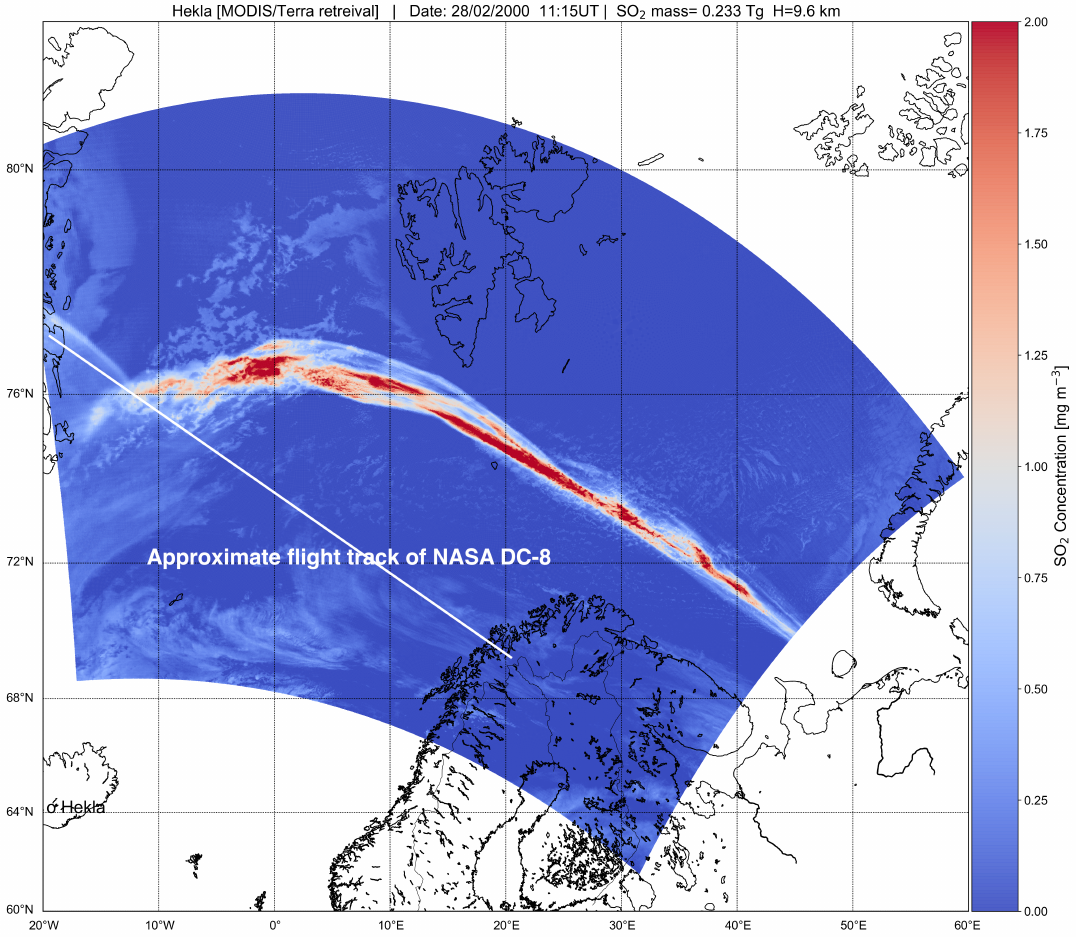
Figure 20. MODIS/Terra SO 2 retrieved concentrations for a plume from the 28 February 2000 eruption of Hekla, Iceland. Concentrations were determined using independent NASA DC-8 aircraft observations of the plume height and thickness and validated against in situ aircraft SO 2 data.